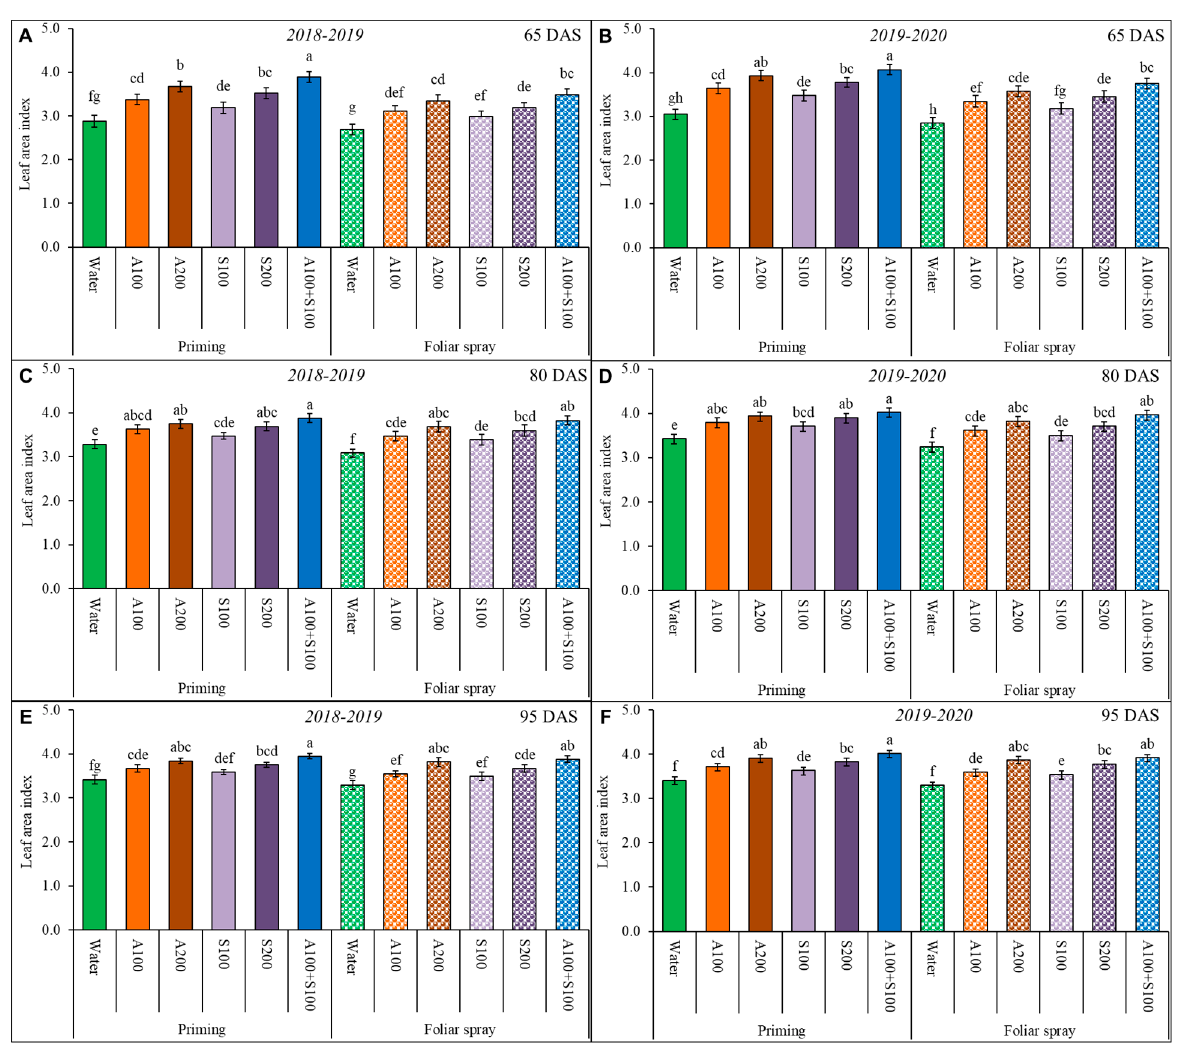
Figure 1. Leaf area index (LAI) of wheat affected by AA and SA treatments in two winter seasons 2018/2019 and 2019/2020; ( A , B ) LAI at 65 DAS, ( C , D ) LAI at 80 DAS, ( E , F ) LAI at 95 DAS. Data are mean ± standard error ( n = 4). Letters represent significant differences between treatments at p < 0.05 level according to the LSD test.